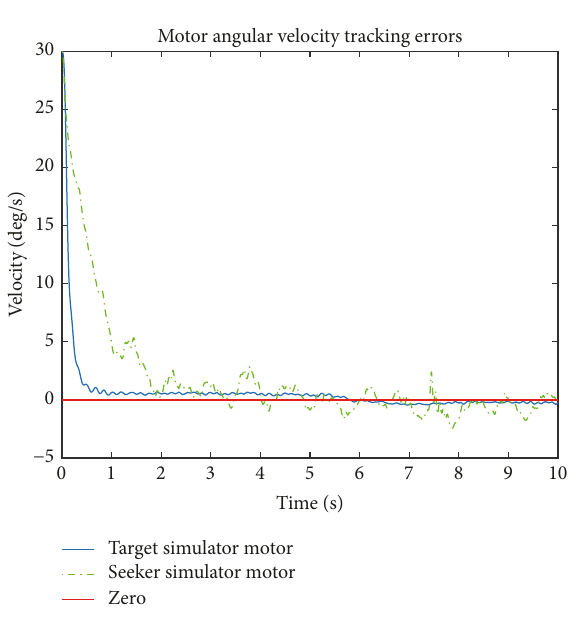
Figure 12: Response of the PID controllers.